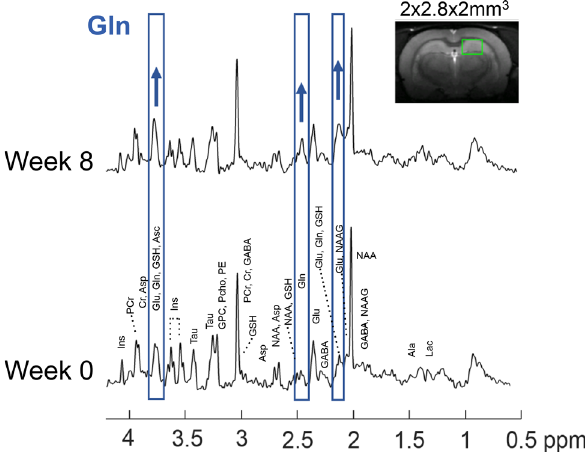
Figure 2. Representative 1 H MRS spectra in the hippocampus of a ‘BDL + rifaximin & probiotics’ rat at week 0 and week 8 after BDL. Part of the spectra corresponding to Gln are shown in blue, which visibly increased from week 0 to week 8. The green rectangle shows the region considered in the hippocampus on the T 2 weighted axial image of the rat brain.